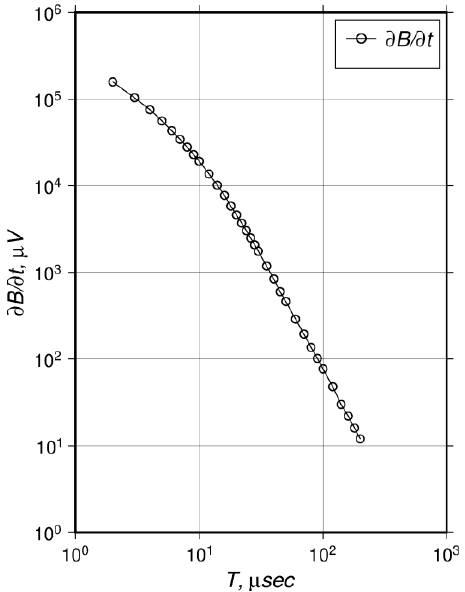
Figure 1. Transient electromagnetic (TEM) decay curve as time dependencies from the beginning of the transient process.